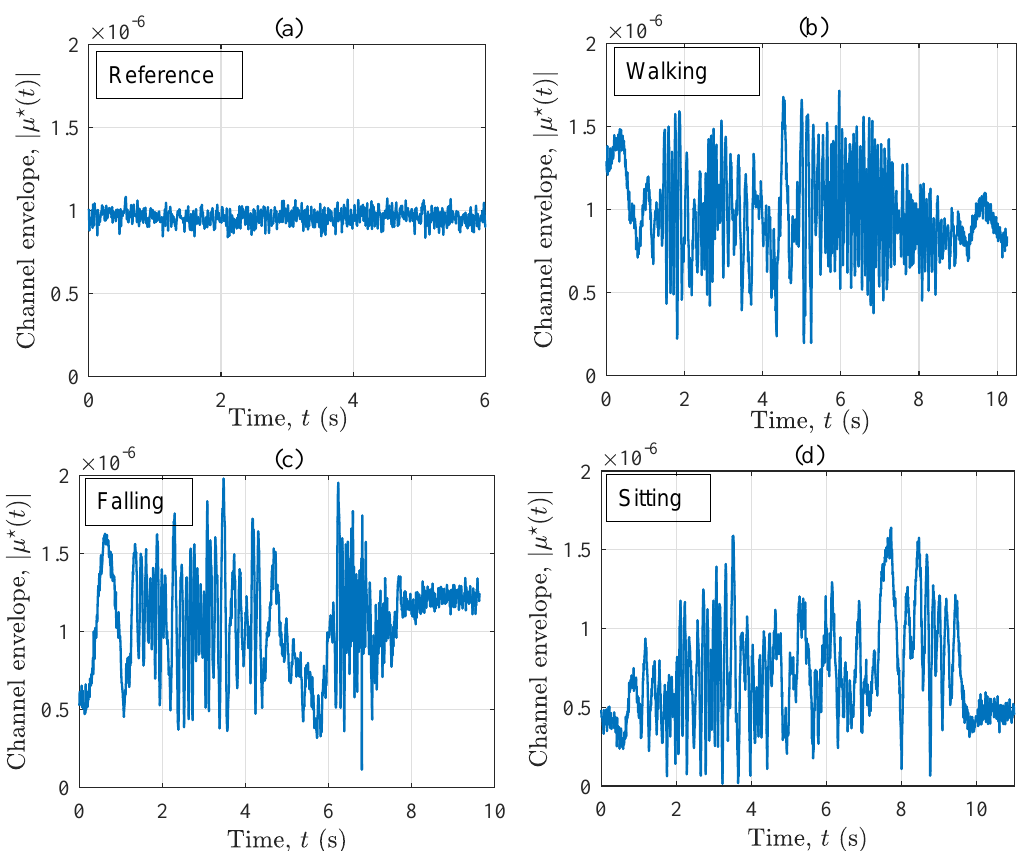
Figure 3. The signal envelope | µ (cid:63) ( t ) | for four scenarios in S1: ( a ) reference, ( b ) walking, ( c ) falling, and ( d )